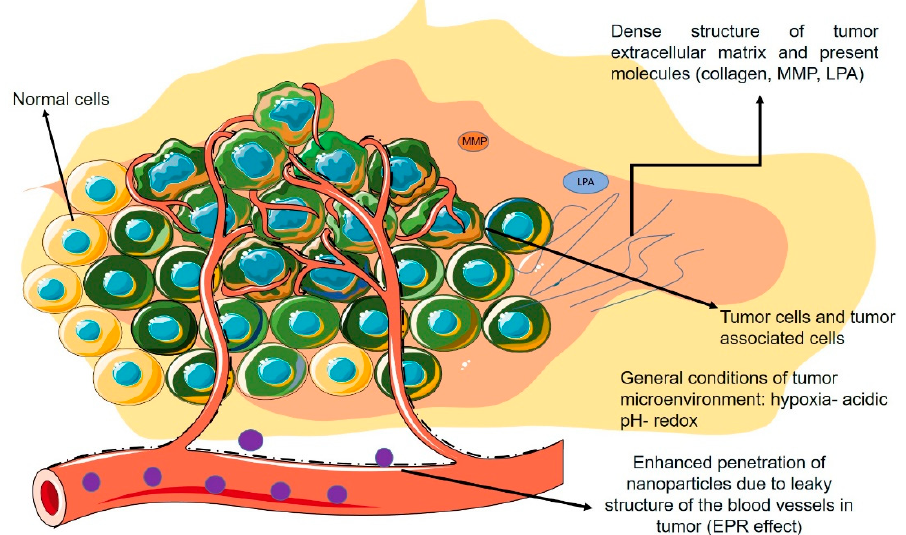
Figure 3. Schematic view of TME and its properties.